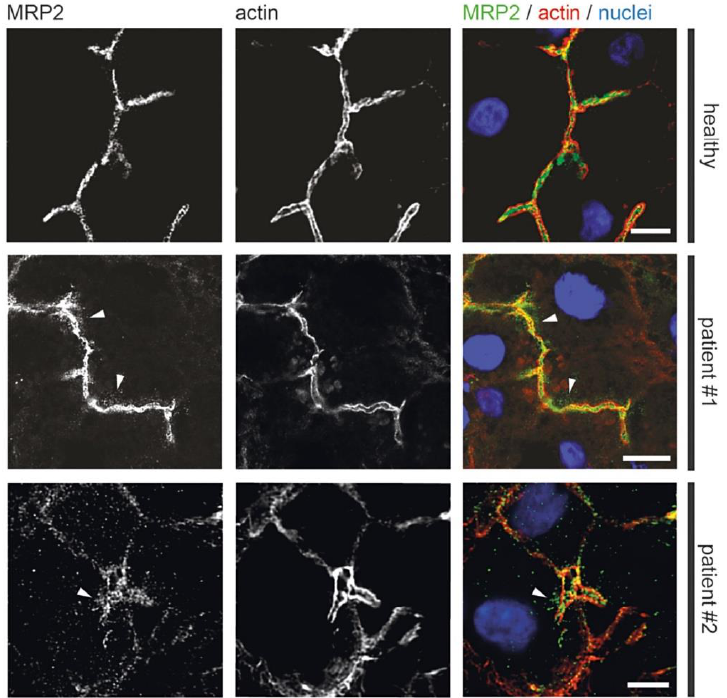
Figure 7. Aberrant localization of apical proteins in MYO5B-PFIC hepatocytes. IF of hepatocytes of patient #1 and #2 show subapical accumulation of MRP2 (arrow-heads) in both patients compared to healthy controls. Bile canaliculus with microvilli indicated by actin staining; scale bars = 5 µm.